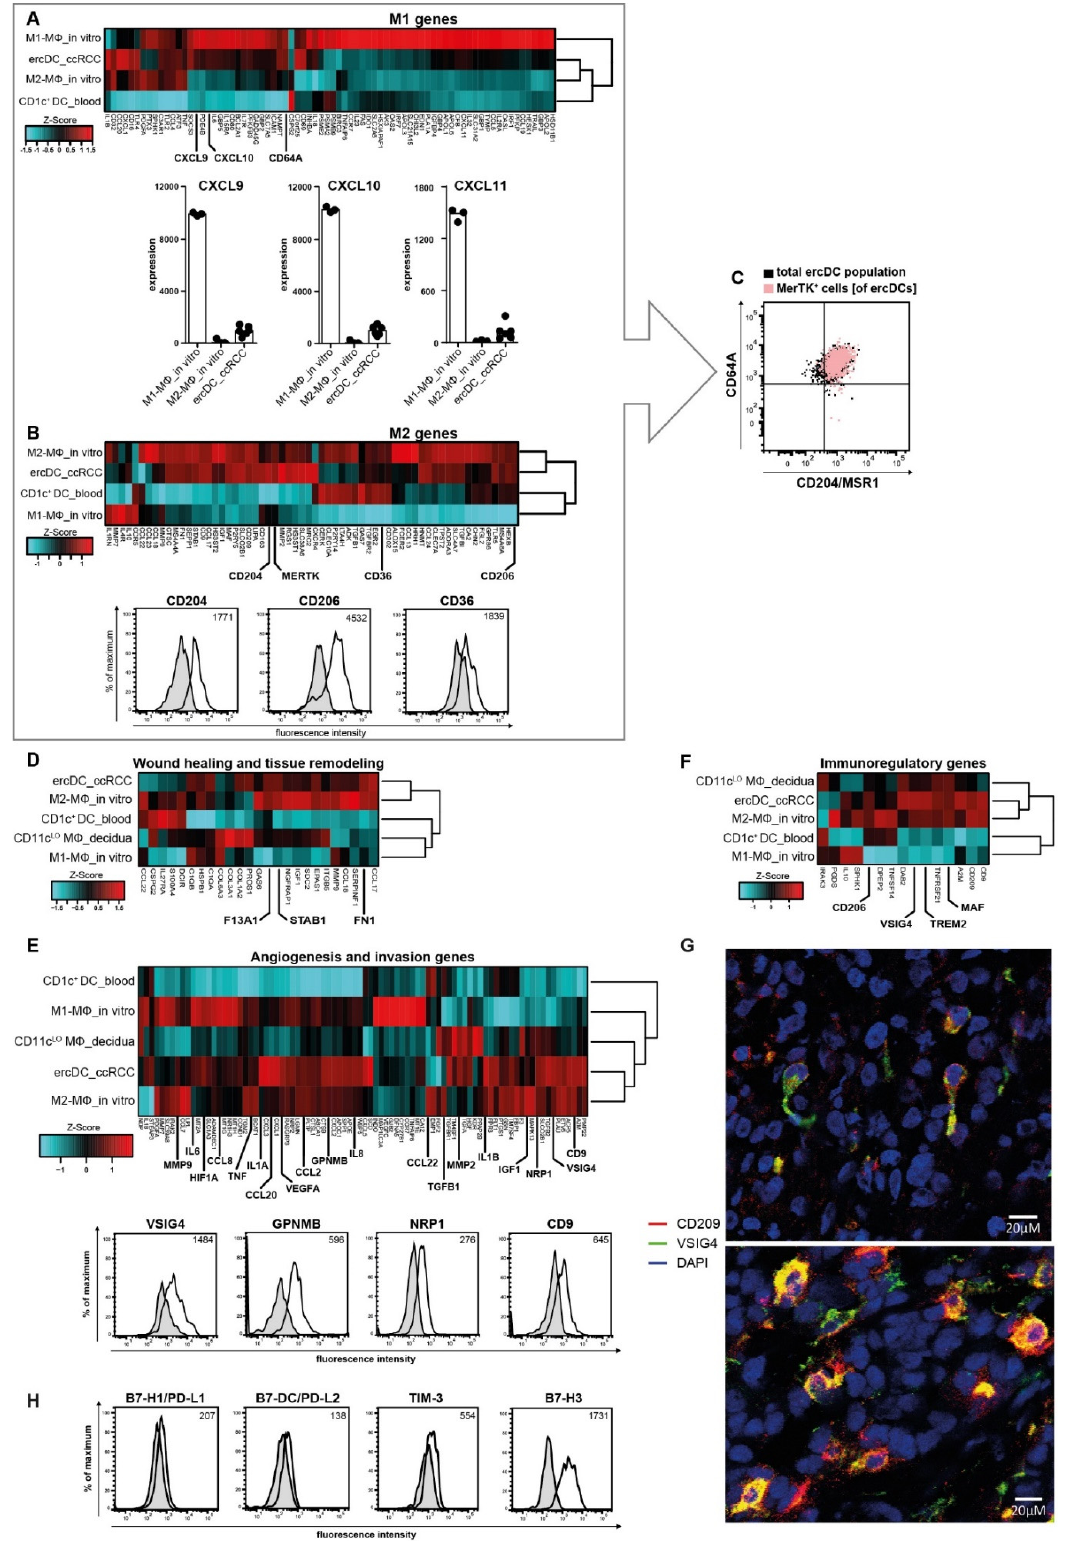
Figure 2. DC- and macrophage-associated genes and genes associated with angiogenesis and invasion in ercDC_ccRCC. ( A , B ) Clustered heatmaps depicts relative expression levels of genes associated with M1- and M2-macrophage polarization. See Tables S5 and S6 for M1- and M2-genes. ( A , bottom) Linear expression of chemokines associated with host defense activity of macrophages. M1-macrophages